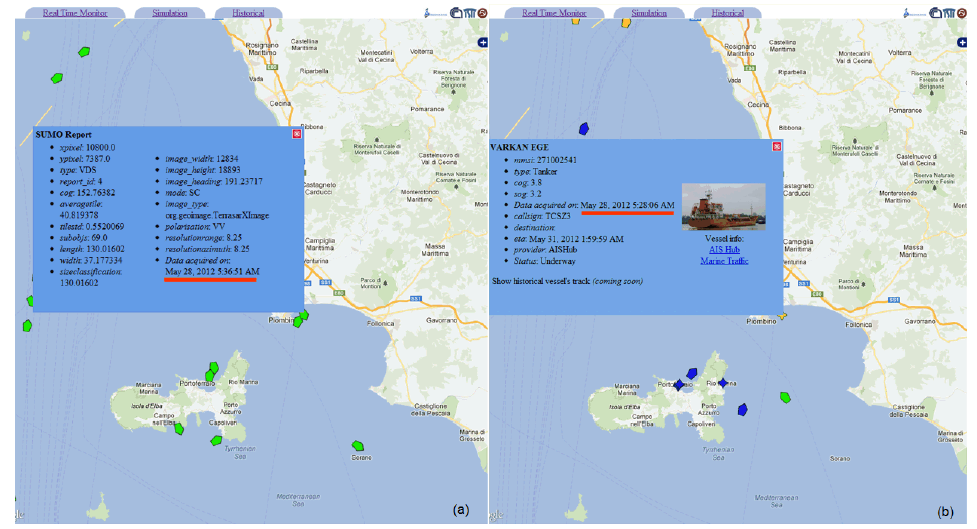
Figure 7. Example of cross correlation between Synthetic-aperture radar processed data ( a ) and AIS acquired data ( b ) following temporal data registration. (scale 1 cm:10